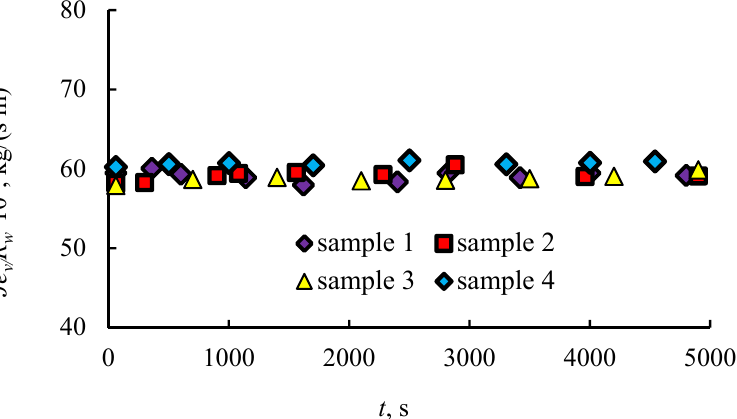
Figure 8. Dependence of J ev / R w with time t for the droplet evaporation ( T w = 41 °C, R w is the droplet radius).